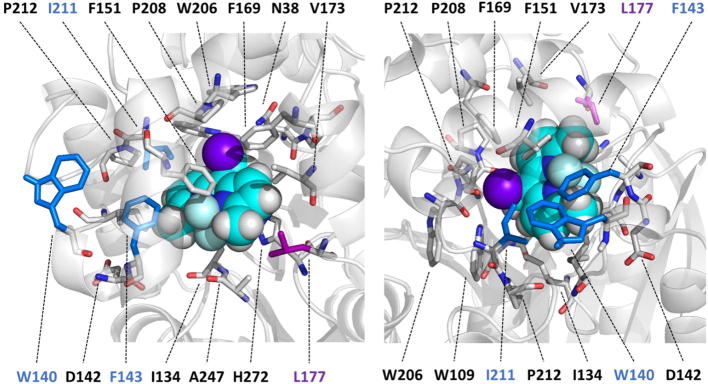
The NAC conformation of BDP in LinBwt viewed from the main tunnel (left) and from the p3 tunnel (right). The cleaved halide (chlorine) of BDP is situated in the middle of the aromatic ring system which causes parts of the molecule to bind to the p3 region while the other side fills the active site almost completely. BDP is shown as spheres, and residues within 4 Å from BDP and the in LinB32 and LinB86 mutated residues are shown as sticks following color scheme of Fig. 1. BDP is shown with the following color scheme: purple = chlorine, cyan = carbon, light cyan = fluorine, blue = nitrogen and white = hydrogen. (For interpretation of the references to color in this figure legend, the reader is referred to the web version of this article.)